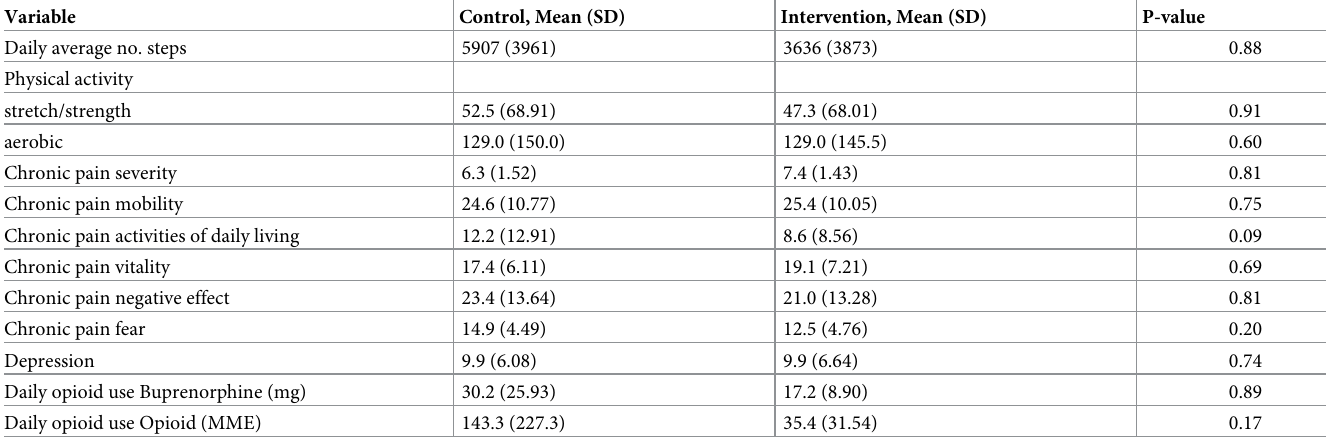
With respect to pain-related interference, no group differences were noted at baseline with walking, interference with activities of daily living, vitality, negative affect, or fear of reinjury (Table 4). Likewise, the percent change of these various pain-related outcomes over 12 weeks between the control and intervention arms did not statistically differ, although there was a trend for the intervention arm to have greater improvement or less worsening of pain interfer- ence scores than the control group (Table 5). Table 4. Mobility and pain measures at